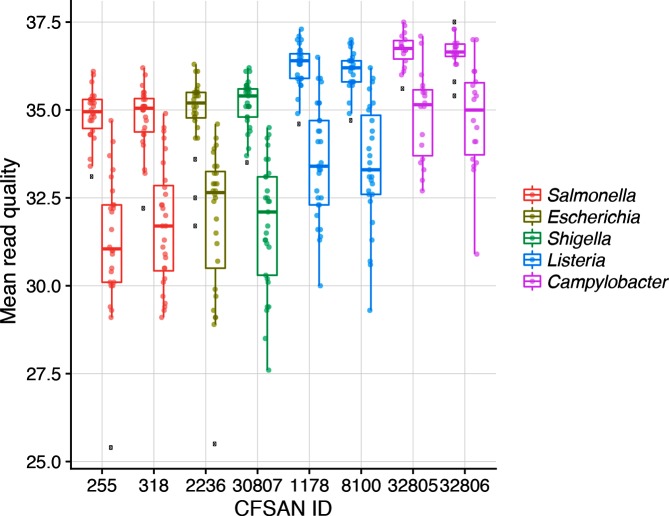
Box and whisker plots summarizing the mean read quality across Read1 and Read2 for each of the eight PT strains. The box defines the median value, as well as the lower and upper quartiles (25 and 75 %). The whiskers extend to the most extreme data point that is no more than 2.5 times the interquartile range from the median. Outliers are shown as black dots. The colours are genus specific.